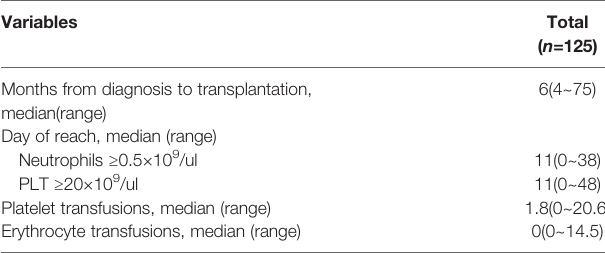
TABLE 4 | Hematologic recovery after ASCT. Variables Total